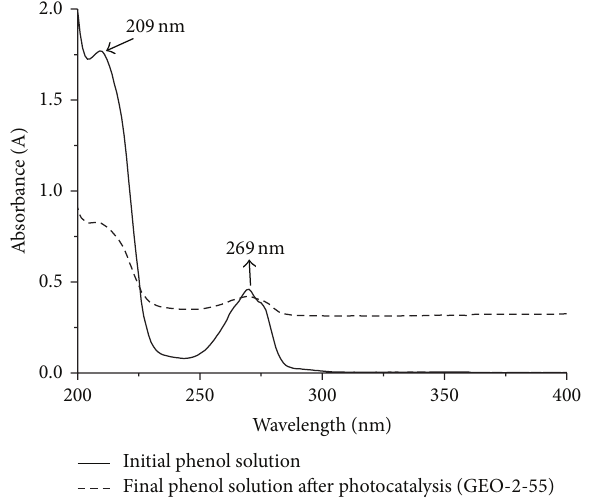
Figure 6: UV-vis spectra of photocatalytic test for phenol solution using GEO-2-55, in the initial and final of reaction